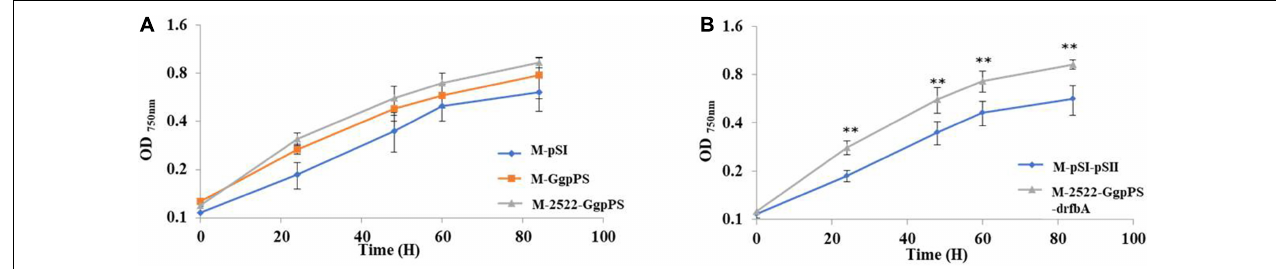
FIGURE 6 | Growth curves of strains under 0.5 M NaCl and 200 µ mol photons m − 2 s − 1 conditions. (A) Growth curves of strains M-pSI, M-GgpPS, and M-2522-GgpPS; (B) growth curves of strains M-2522-GgpPS-pSII and M-2522-GgpPS-drfbA. Statistical analysis was conducted as described in the text, as statistical significance indicated by ∗∗ p <